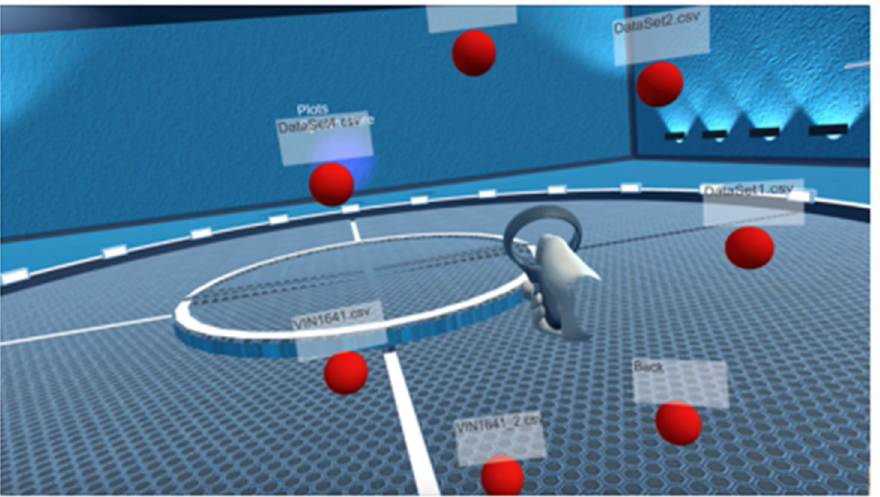
Figure 5. IVEE’s initial steps to building a visualization.